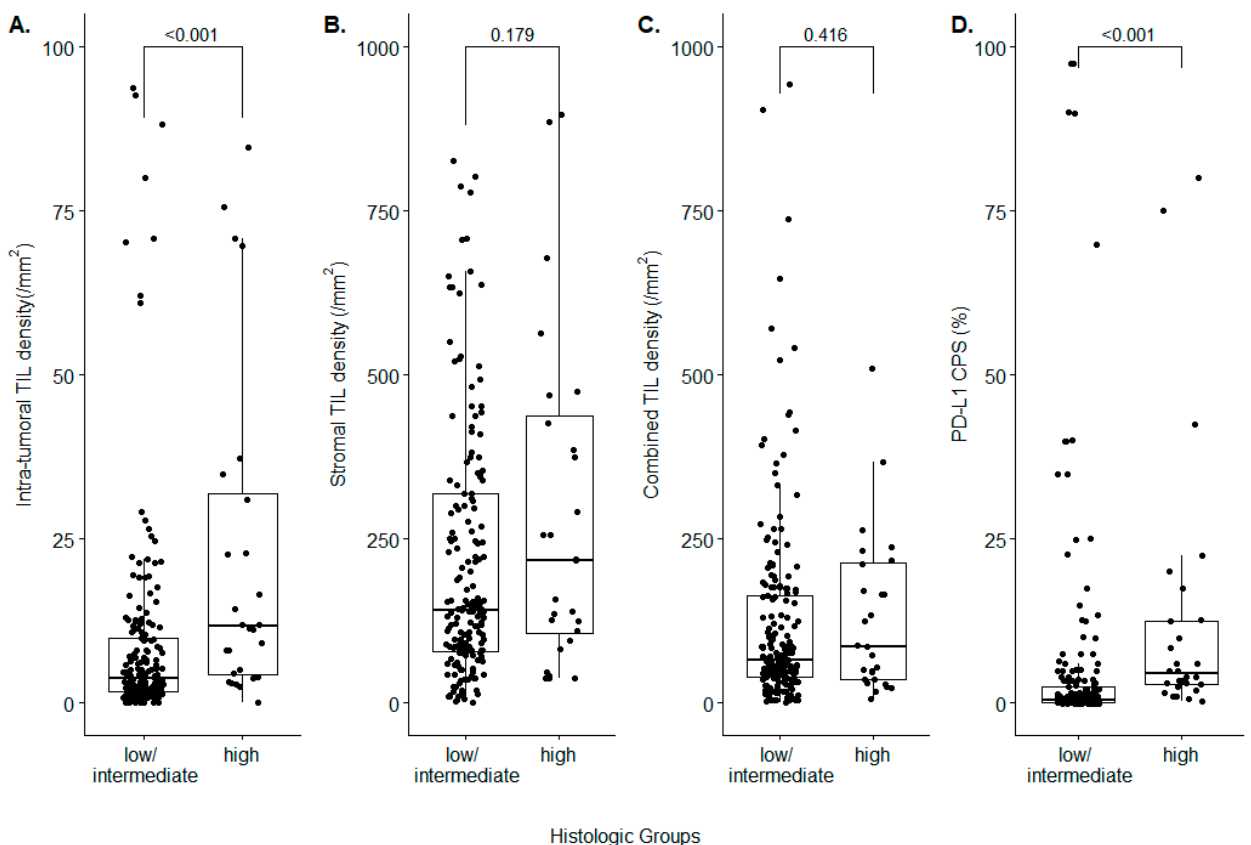
Figure 1. Analysis of the TIL densities and the PD-L1 expression in histologic subgroups of the neuroendocrine neoplasm. ( A ) Intra-tumoral TIL density; ( B ) stromal TIL density; ( C ) combined TIL density; ( D ) PD-L1 CPS.